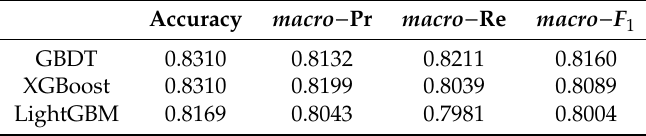
Table 5. Overall prediction results of each algorithm.